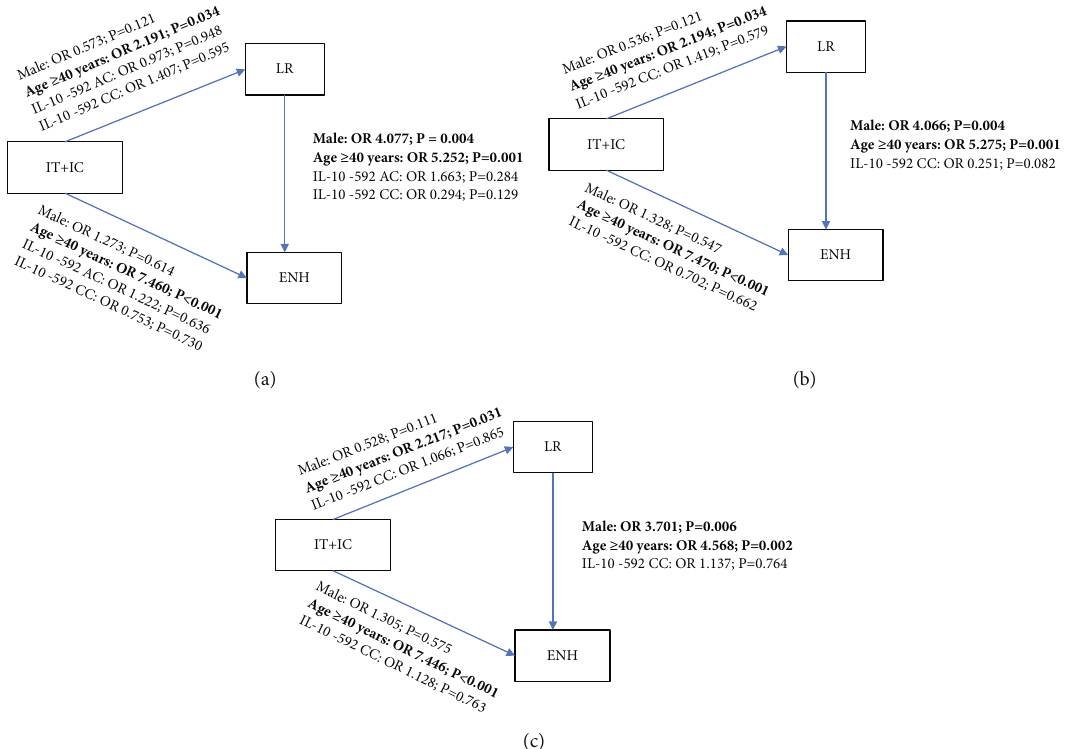
Figure 1: The e ff ect of host factors on CHB phase progression as analyzed using three di ff erent genetic association models. (a) Mendelian assumption model: major homozygote vs. heterozygote and major homozygote vs. minor heterozygote. (b) Dominant assumption model: major homozygote and heterozygote vs. minor homozygote. (c) Recessive assumption model: major homozygote vs. heterozygote and minor homozygote. Host factors analyzed were male gender, age ≥ 40 years, and IL-10 -592 genotype against di ff erent CHB phase progression: IT+IC progression to LR, IT+IC progression to ENH, and LR progression to ENH. Age was signi fi cantly associated with all CHB phase progression in all three genetic association models, while male gender was only signi fi cantly associated with the LR to ENH progression ( P < 0 : 05 ; shown in